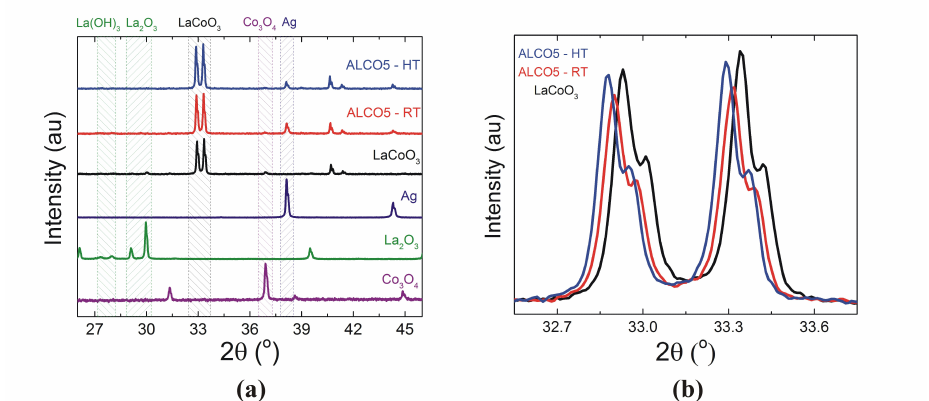
Figure 1. X-ray diffraction spectra of LaCoO 3 and mixed Ag-LaCoO 3 powders, with Ag to LaCoO 3 weight ratio of 1 (sample ALCO5). ( a ) The diffraction patterns of LaCoO 3 powders obtained from lanthanum and cobalt oxide precursors are illustrated, respectively. For comparison, ALCO5 powders mixed at room temperature (ALCO5-RT) and calcined at 1000 ◦ C for 1 h (ALCO5-HT) are shown. ( b ) The relative shift of the main Bragg reflections of the LaCoO 3 phase in ALCO5-RT and ALCO5-HT powders is